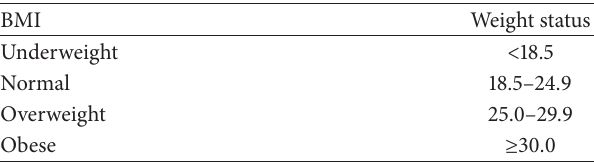
Table 2: CDC BMI ranges for adults. Table 3: Population